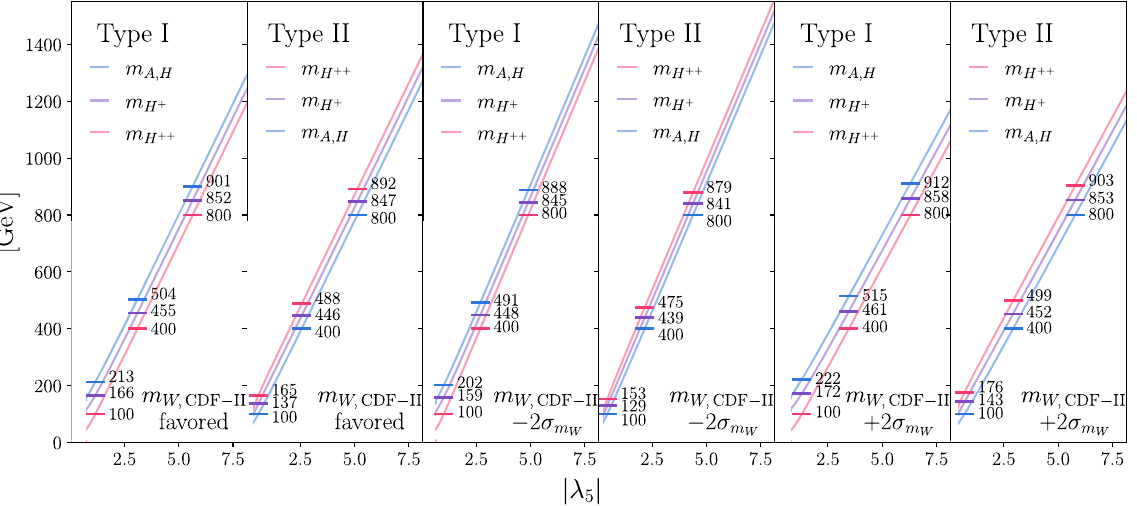
Fig. 2 Mass spectrum of the new Higgs states for a given | λ 5 | that yields the CDF-II measured central values of m W , m W − 2 σ m m W + 2 σ m for the type-I and type-II HTM. We exclude the mass spec- W trum that corresponds m H ++ < 42 . 9GeV (excluded by Z decays [94])